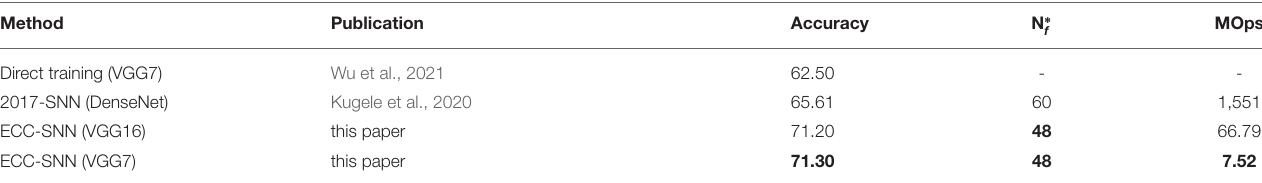
TABLE 2 | Comparison of SNN accuracy, latency, and energy consumption (MOps), between direct training, 2017-SNN and ECC-SNN, for Cifar-10-DVS.